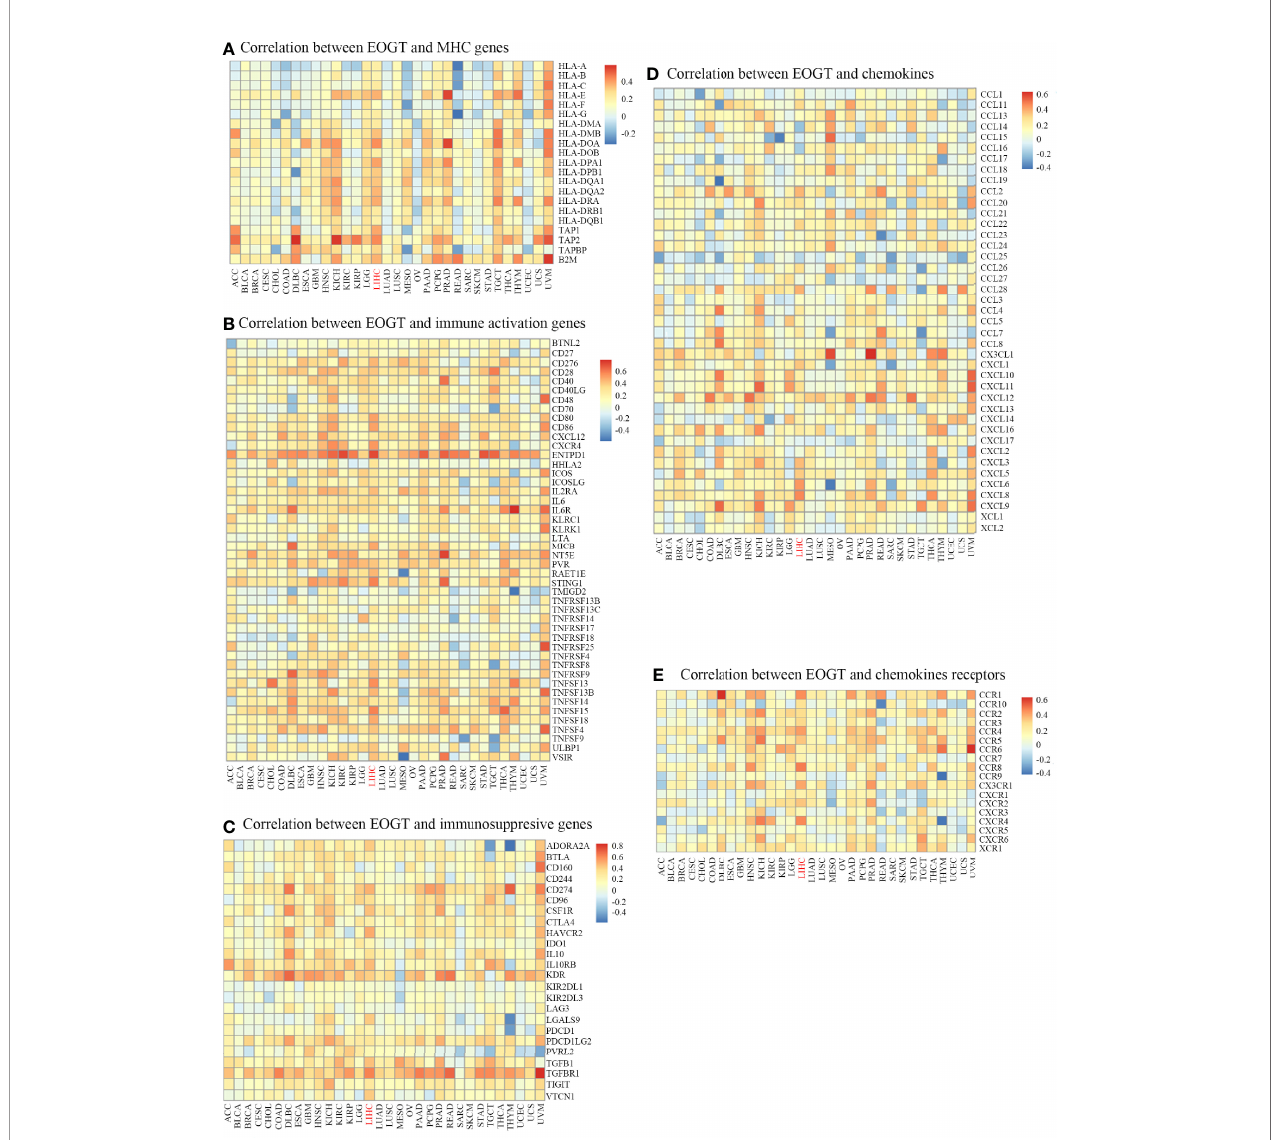
FIGURE 7 | Co-expression of EOGT and immune-related genes. Correlation between EOGT and MHC genes (A) , Correlation between EOGT and immune activation genes (B) , Correlation between EOGT and immunosuppresive genes (C) , Correlation between EOGT and chemokines (D) , Correlation between EOGT and chemokines receptor (E)